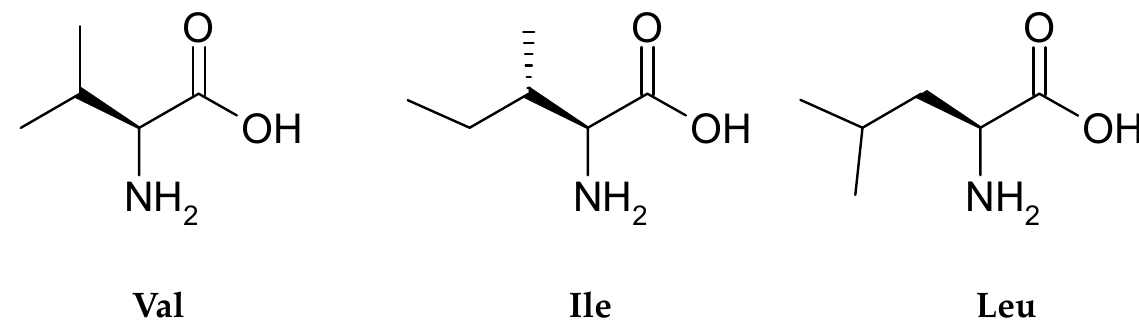
Figure 1. Chemical structures of branched-chain amino acids (BCAA)—valine (Val), isoleucine (Ile), and leucine